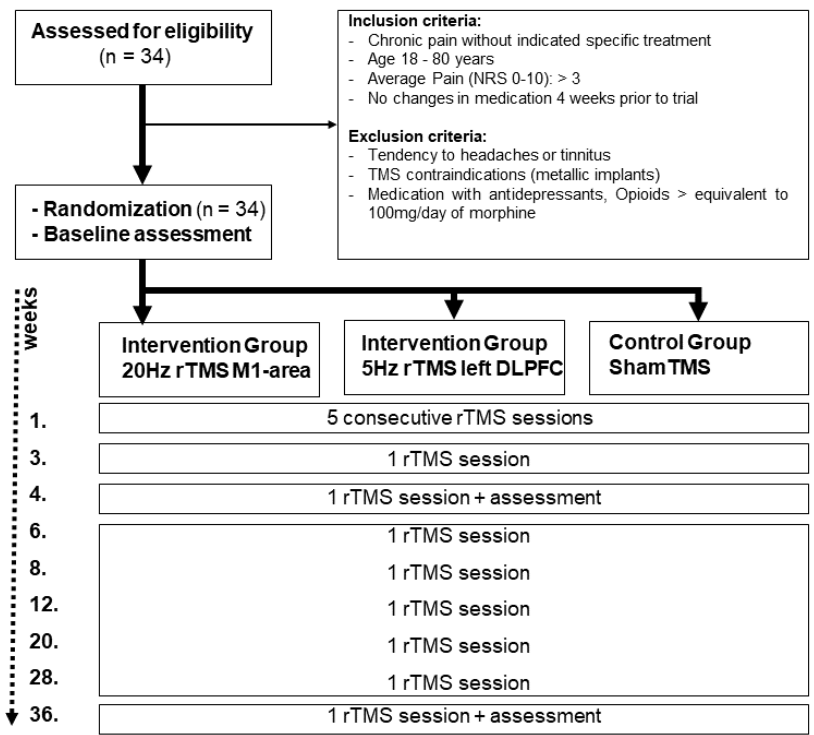
Figure 1. Flowchart depicting the course of the study (CONSORT 2010).